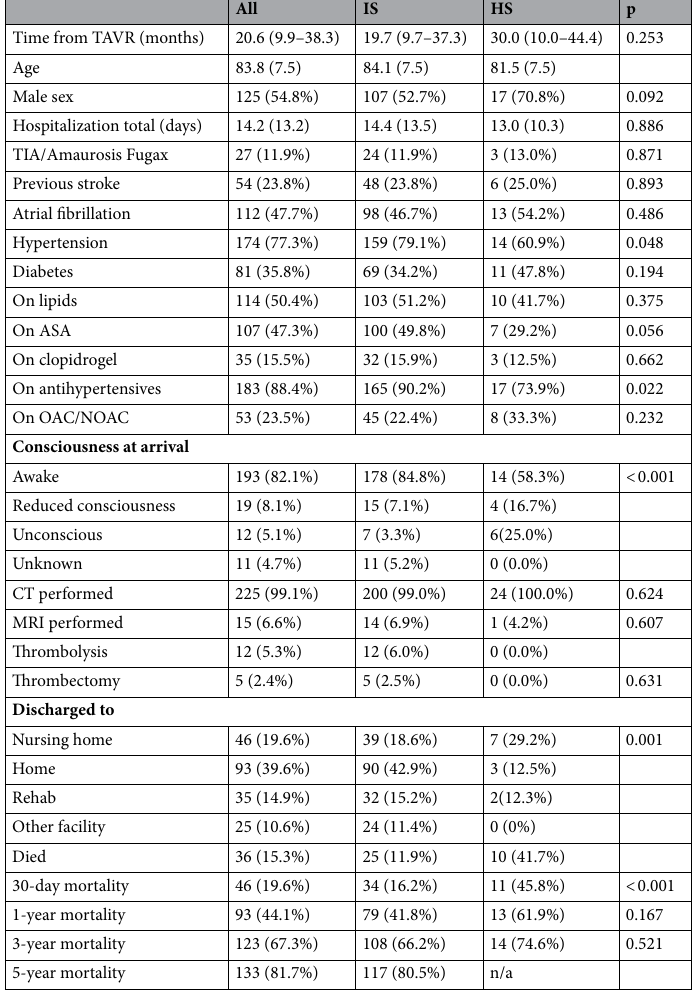
Table 2. Characteristic of patients suffering a stroke. IS Ischemic stroke, HS haemorrhagic stroke, TAVR transcatheter aortic valve replacement, TIA transient ischemic attack, ASA acetylsalicylic acid, (N) OAC (NEW) oral anticoagulation, CT computed tomography, MRI magnetic resonance imaging.